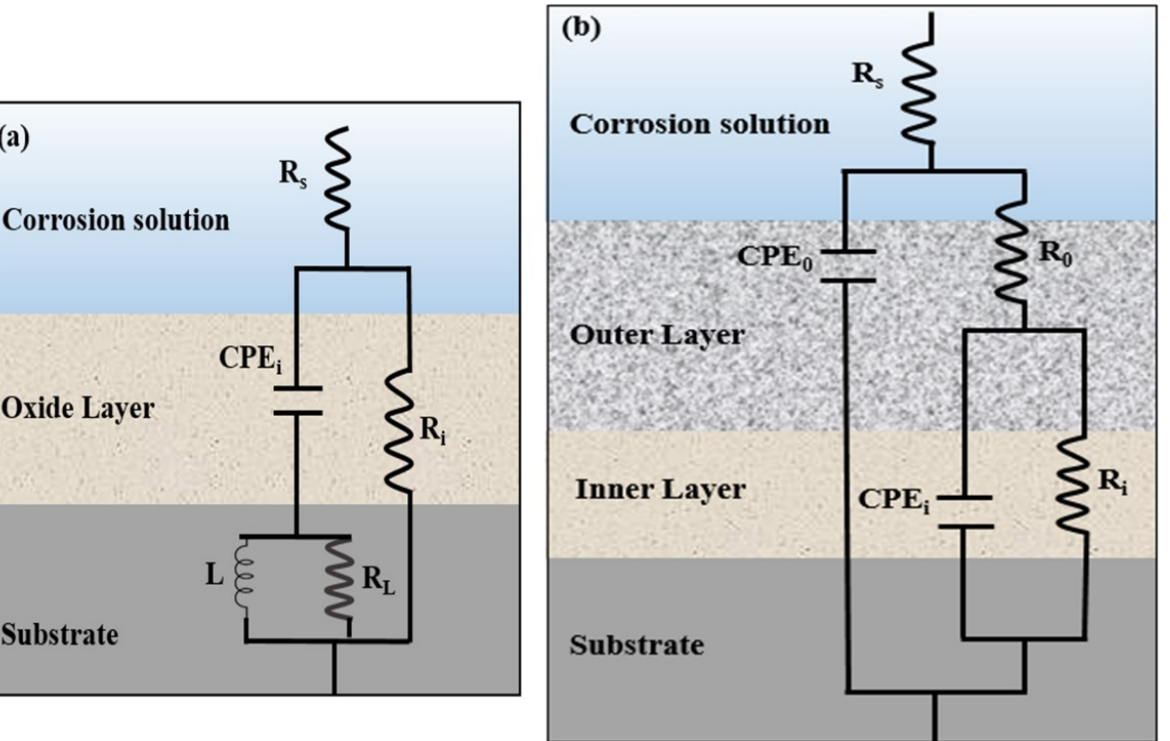
Figure 11. Schematic of electrical equivalent circuits of ( a ) uncoated Mg alloy and ( b ) PEO coatings.